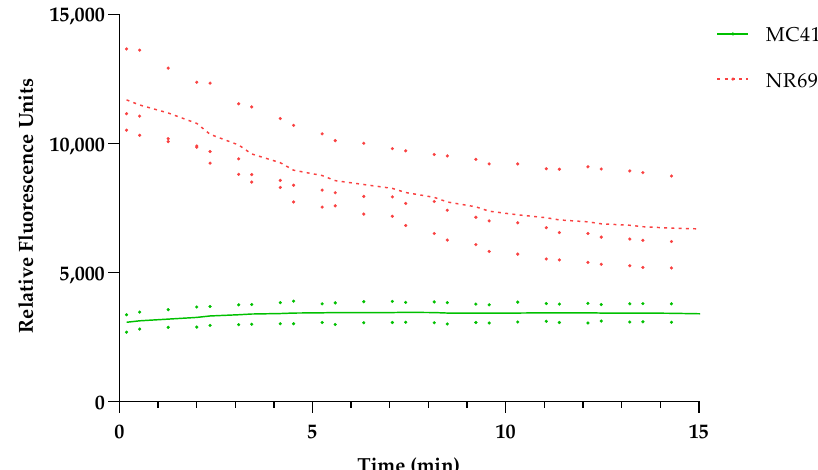
Figure 3. E. coli MC4100 and NR698 cells were used to detect fluorescence resulting from OM permeability to the small hydrophobic molecule 1-N-phenylnapthylamine (NPN). The data points represent two (MC4100, solid shade of green) or three (NR698, dashed shade of red) independent measurements normalized to the water-treated control (bacteria in 5 mM HEPES buffer). The mean is represented by the line of the same color.